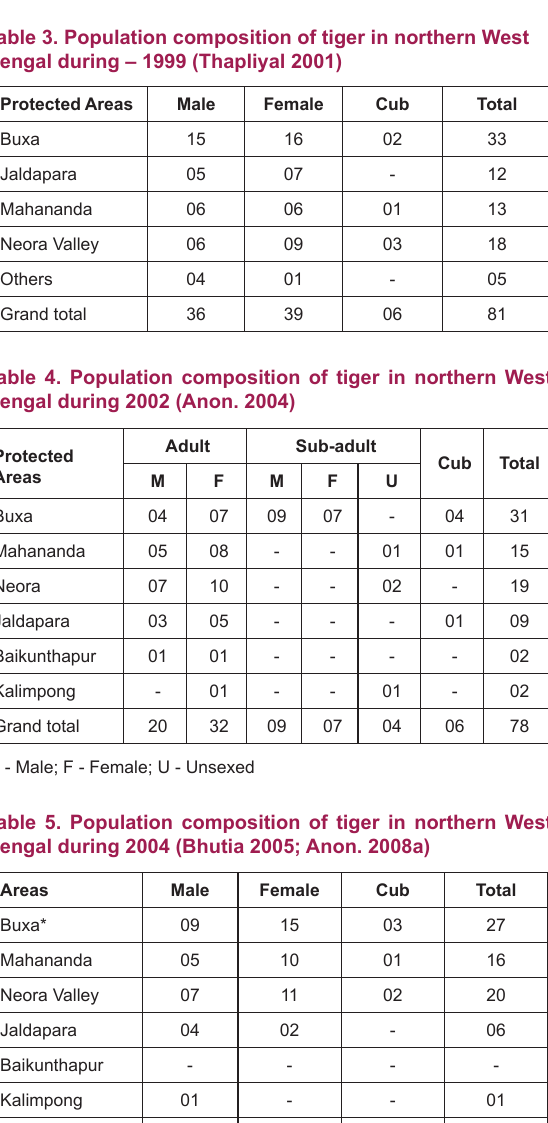
*The hilly forest tract bordering Bhutan could not be fully covered during the census, because of operation “ALL CLEAR” in Bhutan.